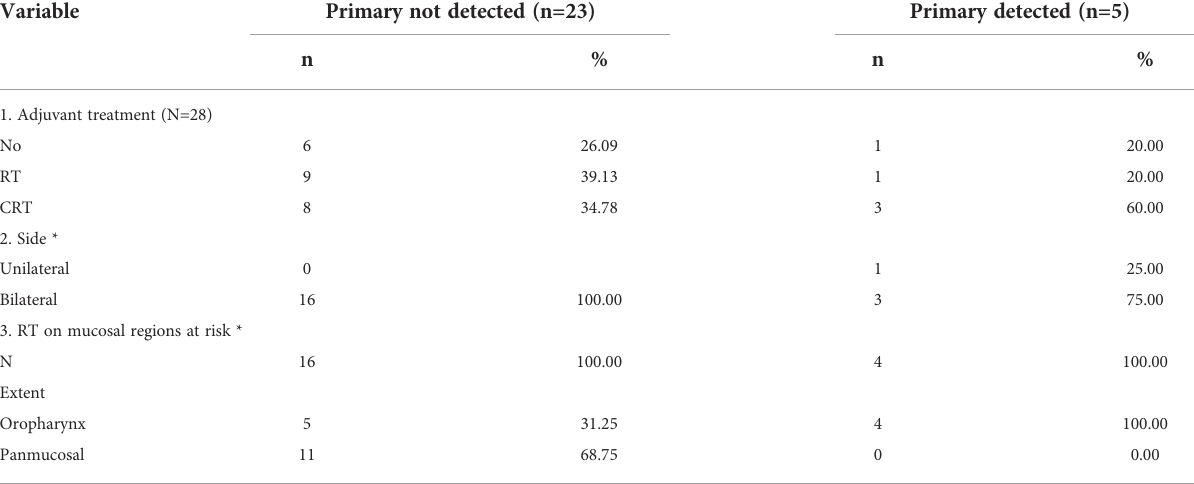
TABLE 6B TORS/TLM subgroup analysis: Comparison of adjuvant treatment characteristics according to primary tumor detection.